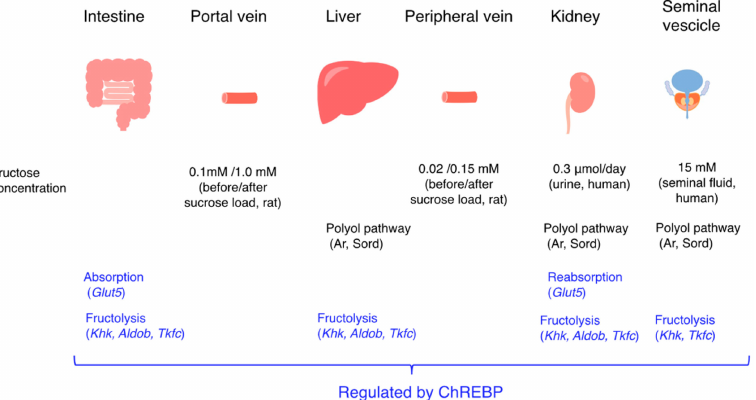
Figure 2. Fructose promotes intestinal and liver fructose metabolism through Chrebp activation. Chrebp regulates Glut5 , Khk , and Aldob expression and then promotes intestinal fructose absorption and hepatic fructose metabolism (de novo lipogenesis and glucose production). The changes in fructose concentration in the portal vein and in the peripheral vein after sucrose loading are also indicated. Fructose concentrations in human urine and seminal fluid are also indicated. In the seminal vesicles, Aldob was not